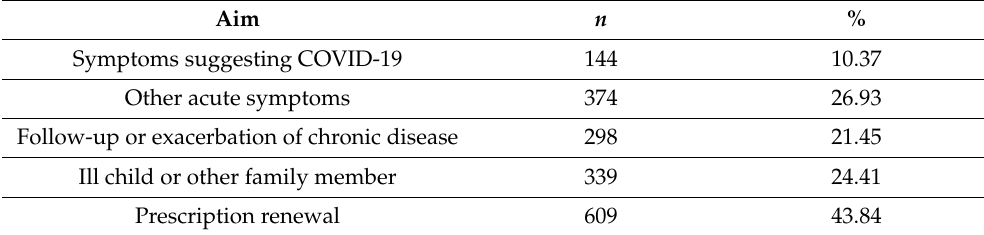
Table 3. The aims and modes of the televisits during the COVID-19 pandemic ( n = 1389).